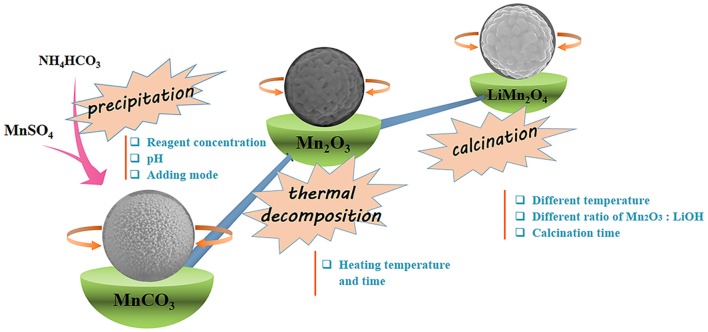
Schematic of the preparation of the spinel LiMn2O4 porous microspheres.